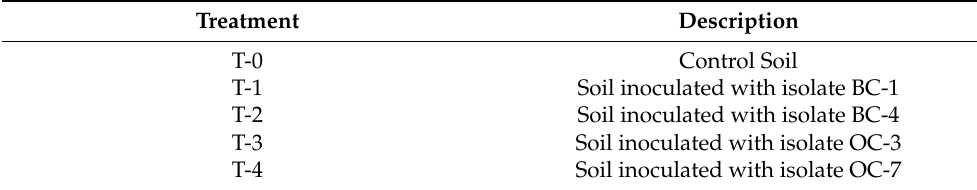
Table 1. Prepared treatments to observe the effects of isolates’ inoculation of S. lycopersicum